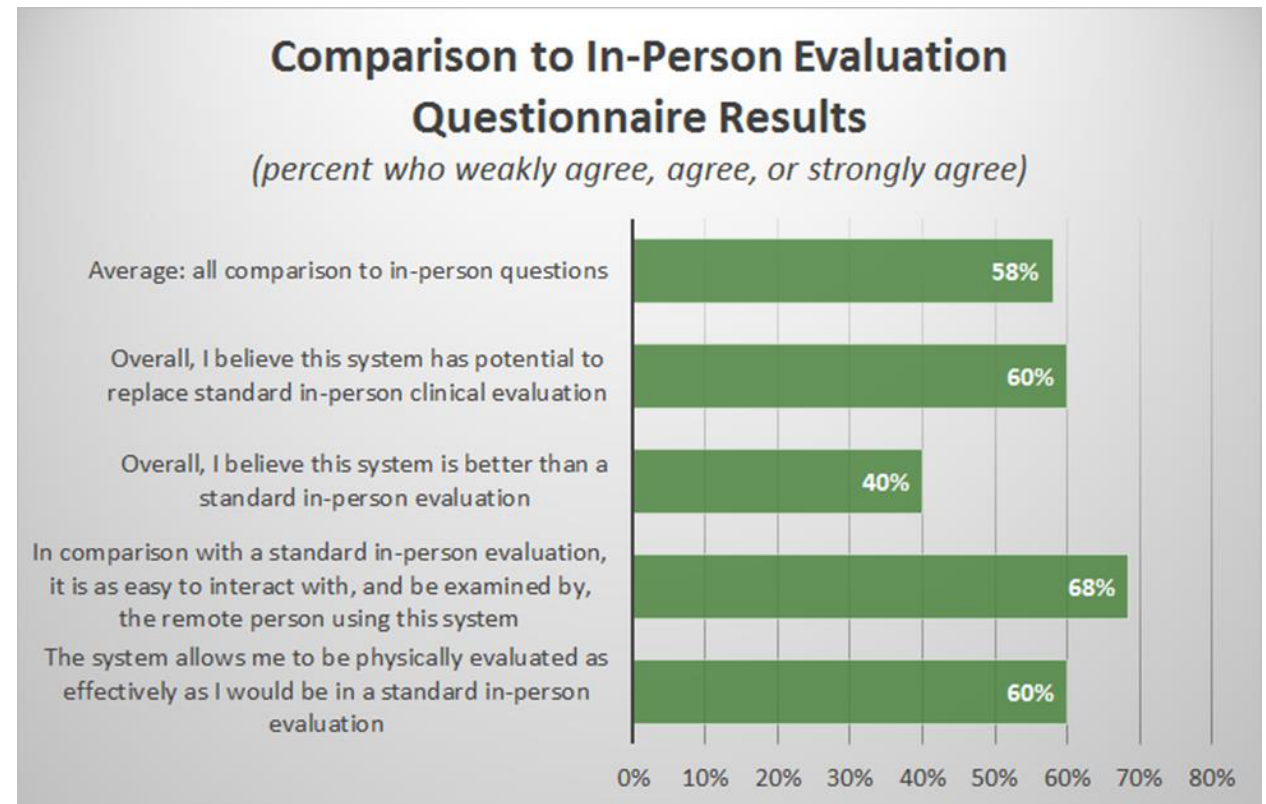
Figure 5. Results of “Comparison to In-person Evaluation” section of telehealth usability questionnaire reported as percent of respondents who rated > 4 on a 7-point Likert scale (corresponding to “weakly agree”, “agree”, or “strongly